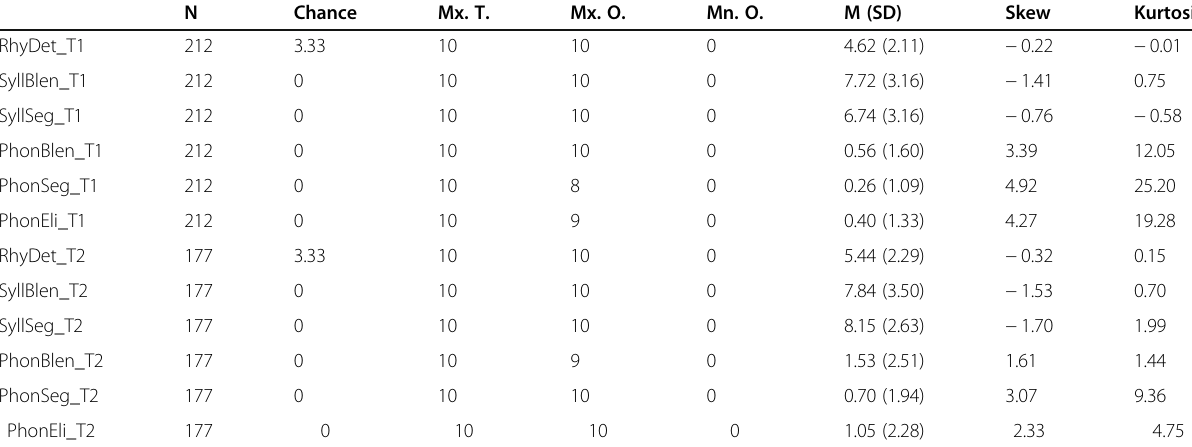
Table 1 Descriptive statistics of the phonological awareness tasks N Chance Mx. T. Mx.